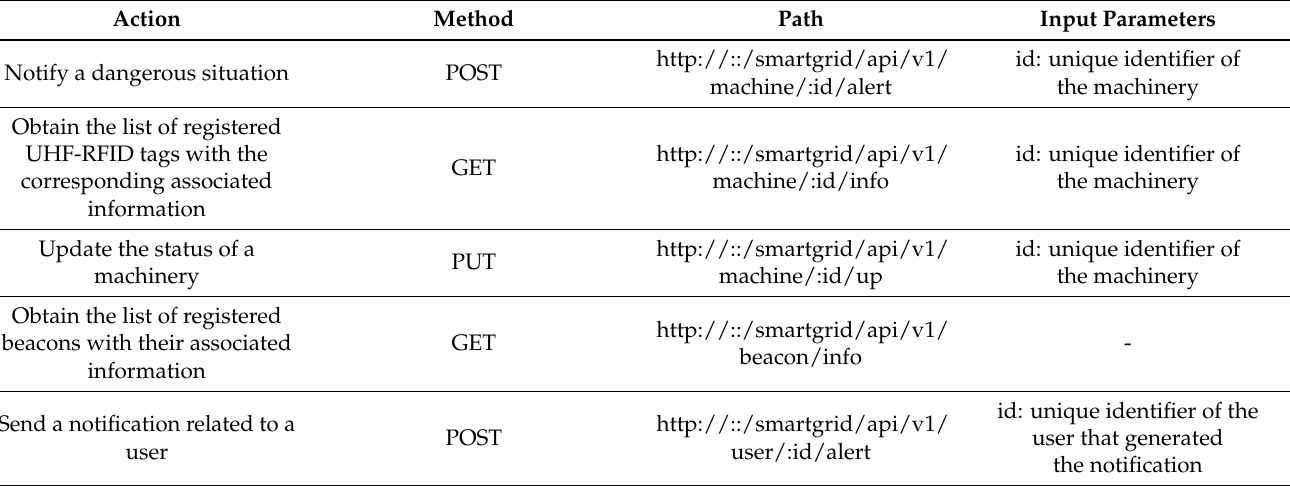
Table 2. APIs exposed by the